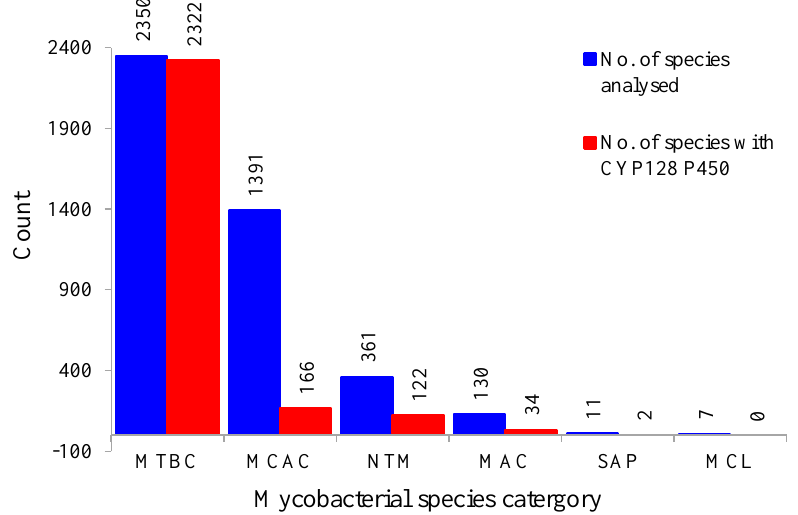
Figure 2. Comparative analysis of the CYP128 P450s in six different mycobacterial categories. Abbreviations: MTBC, Mycobacterium tuberculosis complex; NTM, non-tuberculosis